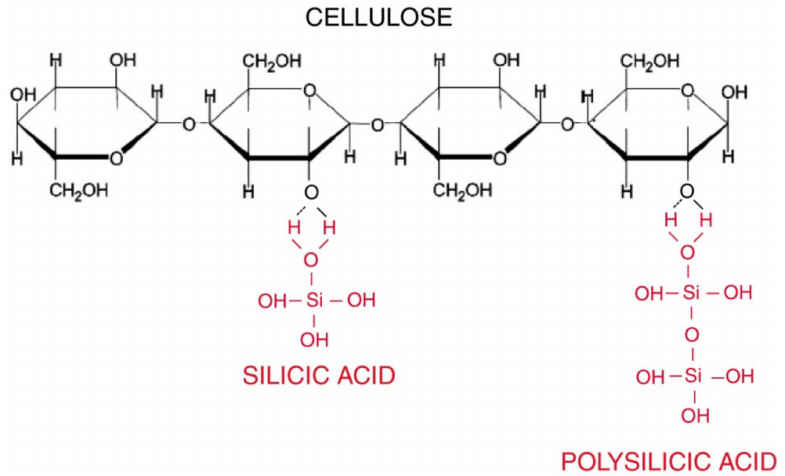
Figure 2. Silicic acid forms hydrogen bonds to OH groups in organic molecules like cellulose. Subsequent polymerization results from Si–O bonds. Silicic acid groups are shown in red. This silica bonding can eventually produce a silica layer on the inner surface of the cell